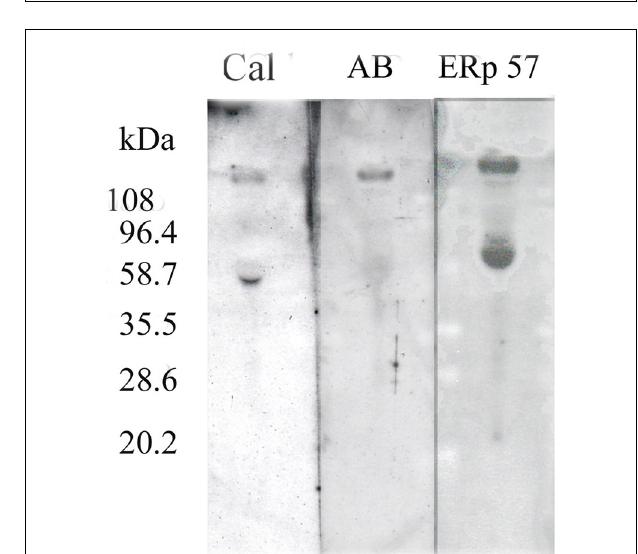
FIGURE 5 | Immunoopurification of theA β -ERp57 Complex from Human CSF. A β and ERp57 were isolated by immunoprecipitation.The samples were then purified by western blotting on sodium docecyl sulfate-polylacrylamide gel electrophoresis.The bands were identified by antibodies to ERp57 (A) and A β (B) . (Taken from Erickson etal., 2005)